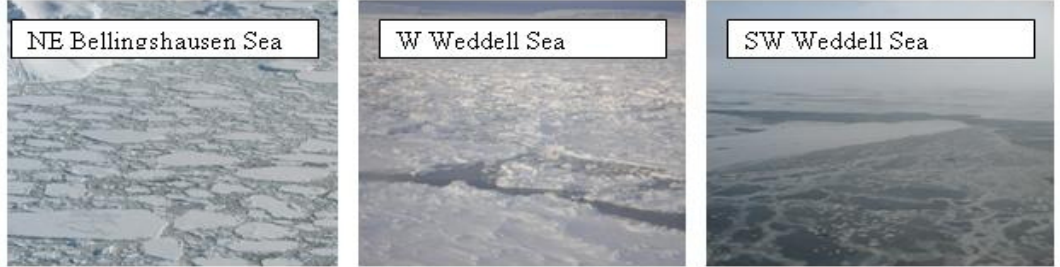
Fig. 2. Pictures of typical sea ice conditions during the field campaign in the north-eastern Bellingshausen Sea (left panel, 26 February 2007), the western Weddell Sea pack ice area (middle panel, 16 February 2007), and the south-western Weddell Sea Ronne Polynya area (right panel, 25 February 2007).